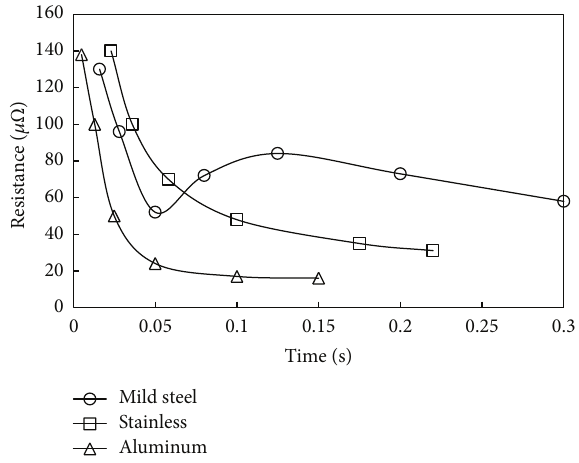
Figure2:Atypicalcurveofdynamicresistanceforweldingdifferent